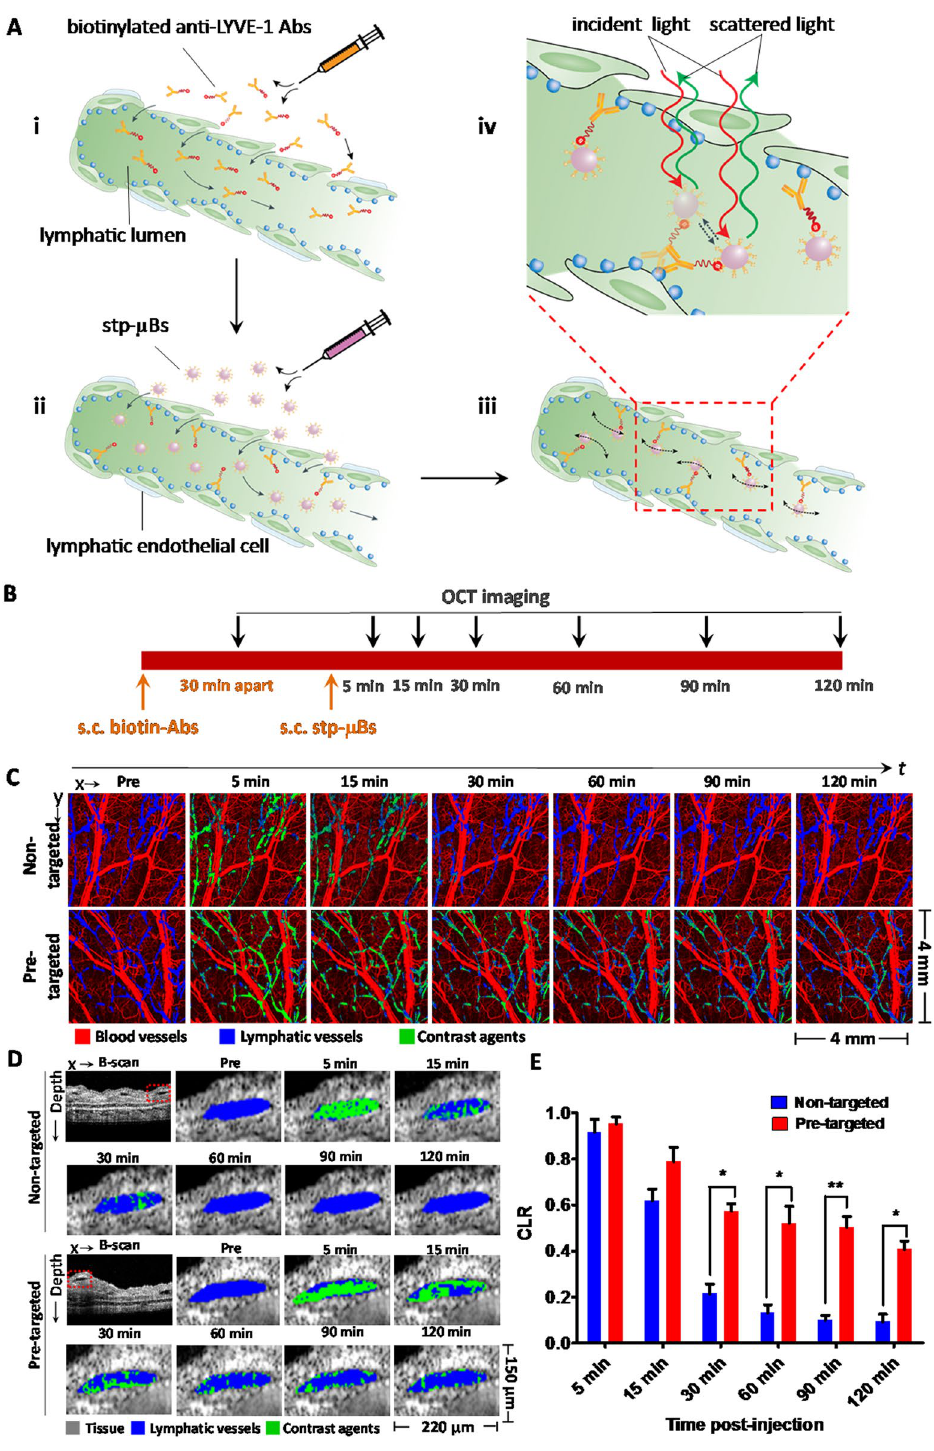
Figure 4. Longitudinal imaging of LYVE-1 targeted µ B in vivo . ( A ) Schematic illustration of LYVE-1 targeting mechanism achieved by the pre-targeting strategy and the PV-OCT method for contrast agent detection. ( B ) The timeline of subcutaneous (s.c.) injections of the contrast agents (orange arrows) and longitudinal OCT imaging time points (black arrows). ( C ) Time-lapse en face merged projection images showing angiogram (red), lymphangiogram (blue), and lymphatic contrast agent signals (green) in the ear tissues of non-targeted and pre-targeted groups of mice before and at various time points following s.c. injection. ( D ) Time-lapse transverse merged images displaying the tissue microstructure (gray), lymphangion (blue), and the contrast agent signals (green) in the ears of non-targeted and pre-targeted groups of mice at pre-injection and various time points post-injection. ( E ) The contrast-to-lymphatic ratios of the non-targeted versus the pre-targeted groups of mice at different imaging time points post-injection. Error bars represent ± SEM (n = 4 mice). * P < 0.05, ** P <